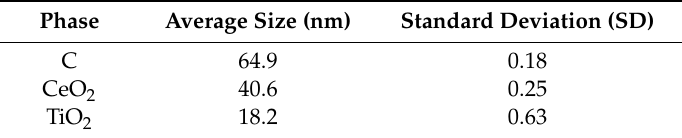
Table 2. Reinforcement phase size from XRD analyses